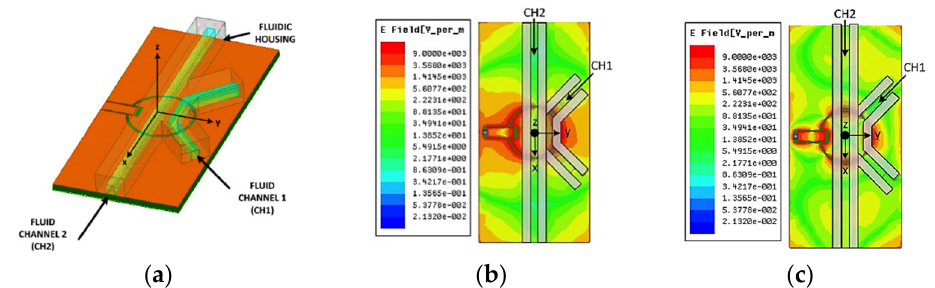
Figure 14. ( a ) The schematic of proposed antenna structure; ( b ) the E-field distribution for first resonating mode (4.2 GHz); ( c ) the E-field distribution for the second resonating mode (8.07 GHz) [40].